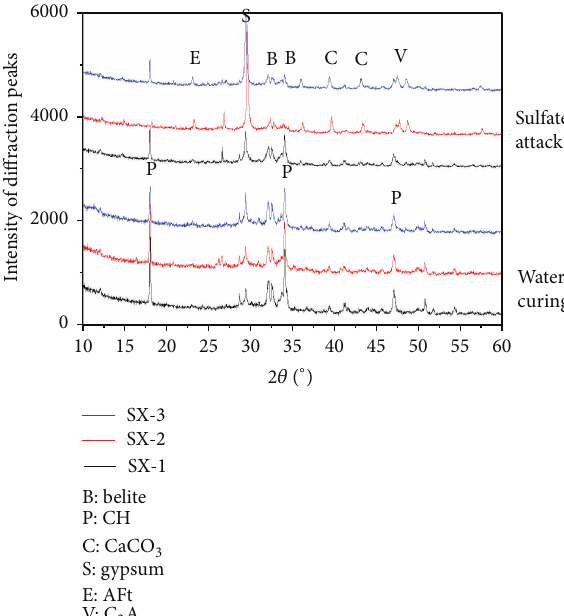
Figure 6: X-ray diffraction (XRD) analysis of samples SX-1, SX-2, and